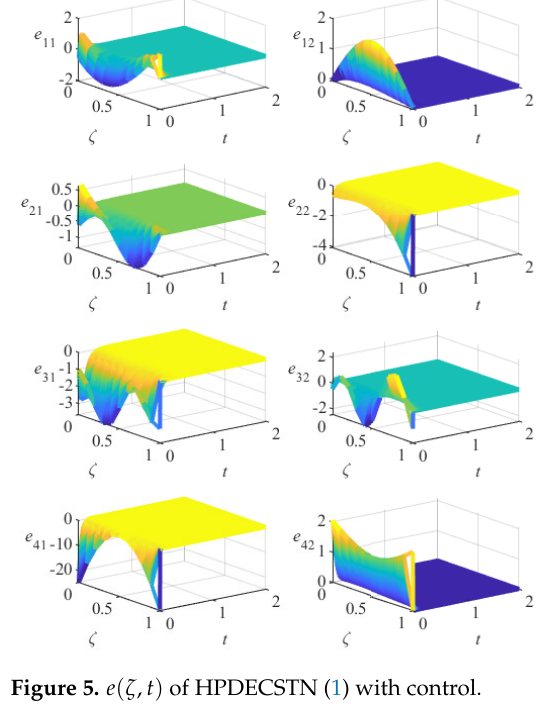
Figure 5. e ( ζ , t ) of HPDECSTN (1) with control.